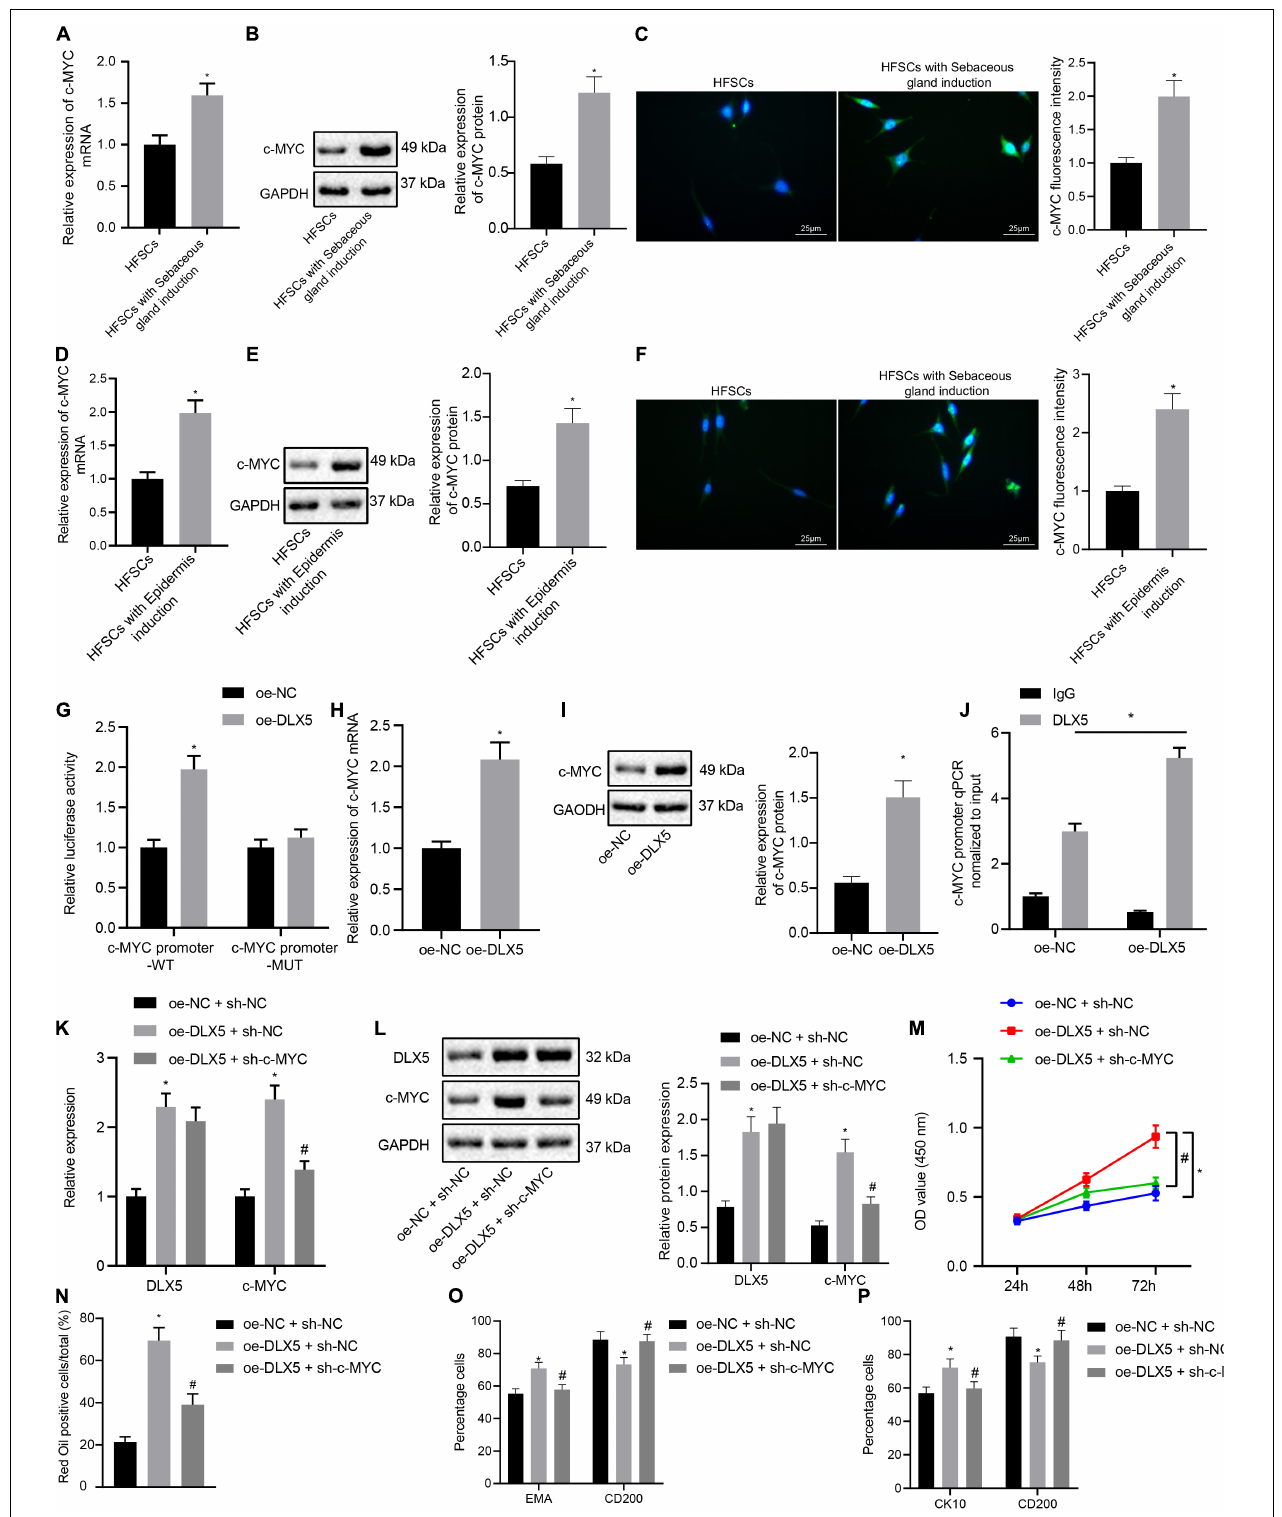
FIGURE 2 | DLX5 promotes the differentiation of HFSCs by up-regulating the expression of c-MYC. (A) c-MYC mRNA expression in HFSCs after differentiation into sebaceous gland cells as determined by RT-qPC. * p < 0.05 compared with HFSCs. (B) c-MYC protein level in HFSCs after differentiation into sebaceous gland cells as determined by Western blot analysis. * p < 0.05 compared with HFSCs. (C) c-MYC fluorescence intensity in HFSCs after differentiation into sebaceous gland cells